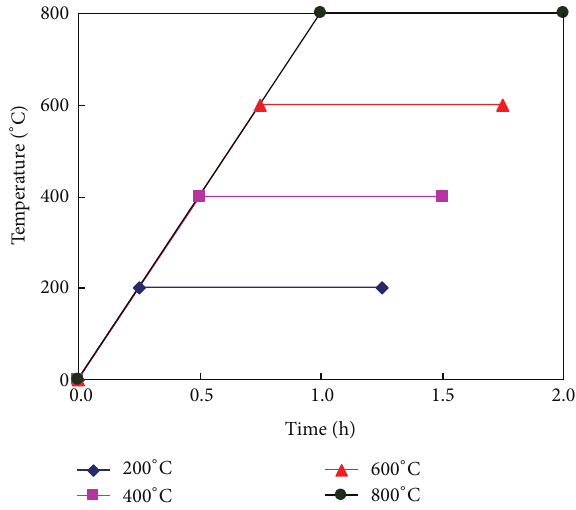
Figure 2: Heating regime for ECC specimens.